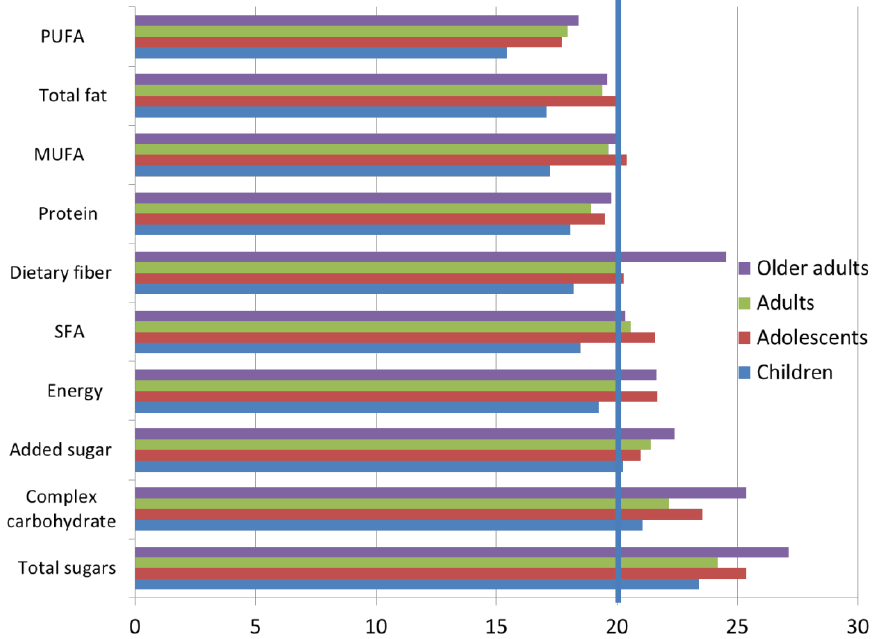
Figure 1. Percent contribution of breakfast to macronutrient intakes relative to energy intakes among breakfast consumers. PUFA stands for Polyunsaturated fatty acids, MUFA stands for Monounsaturated fatty acids, SFA stands for Saturated fatty acids. The 20% cutoff is indicated by a vertical line.